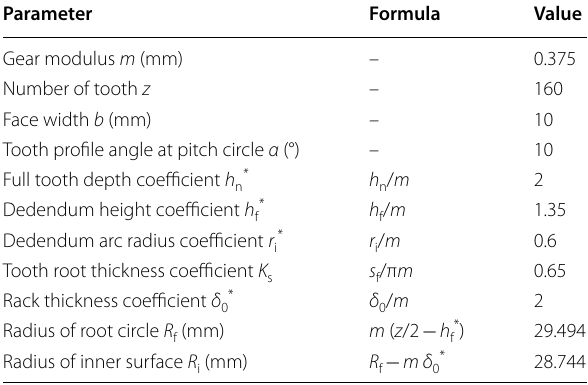
Table 4 Parameters of ring-shaped flexspline